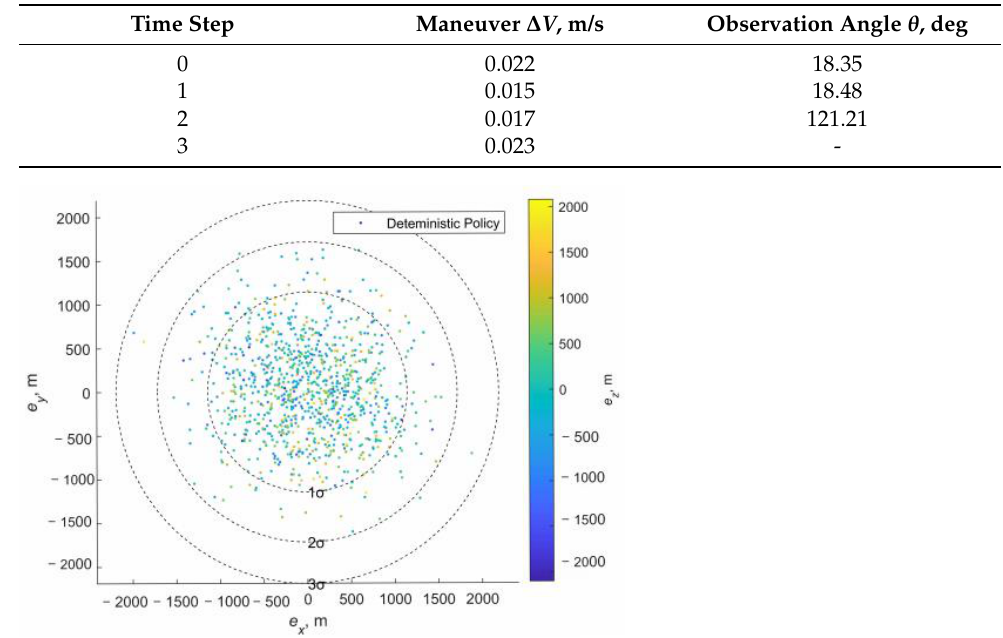
Figure 14. Distribution of the terminal position errors with deterministic guidance and the SaG strategy.